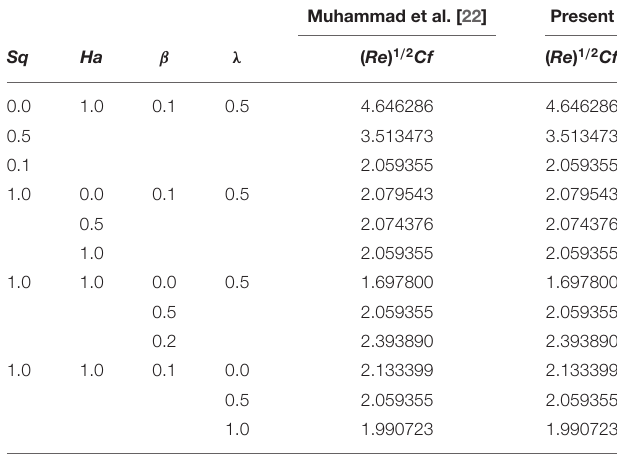
TABLE 1 | Comparison of skin friction co-efficient ( Cf ) for different values of Sq , Ha , β , and λ 1